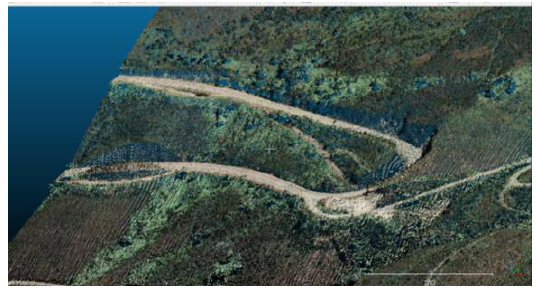
Figure 2. Aerial point cloud from the area of study.